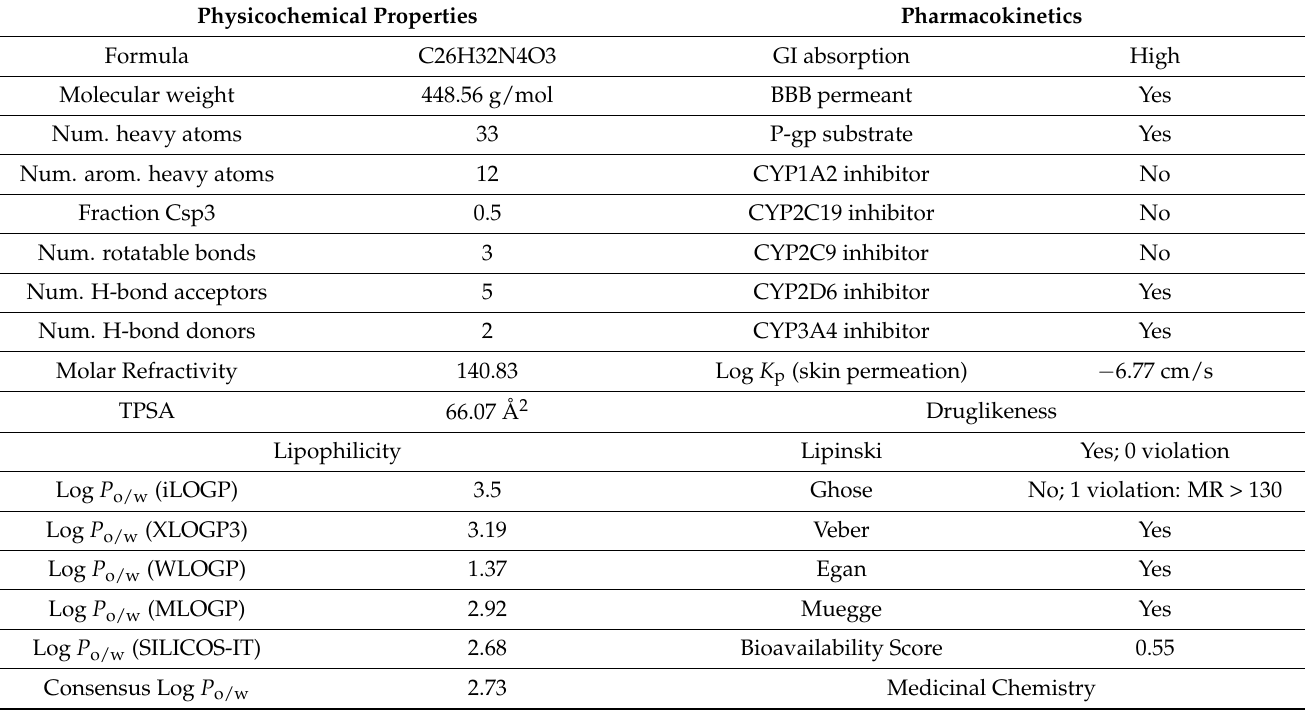
Table 1. SwissADME and preADMET analysis of the hit molecules screened in this study.